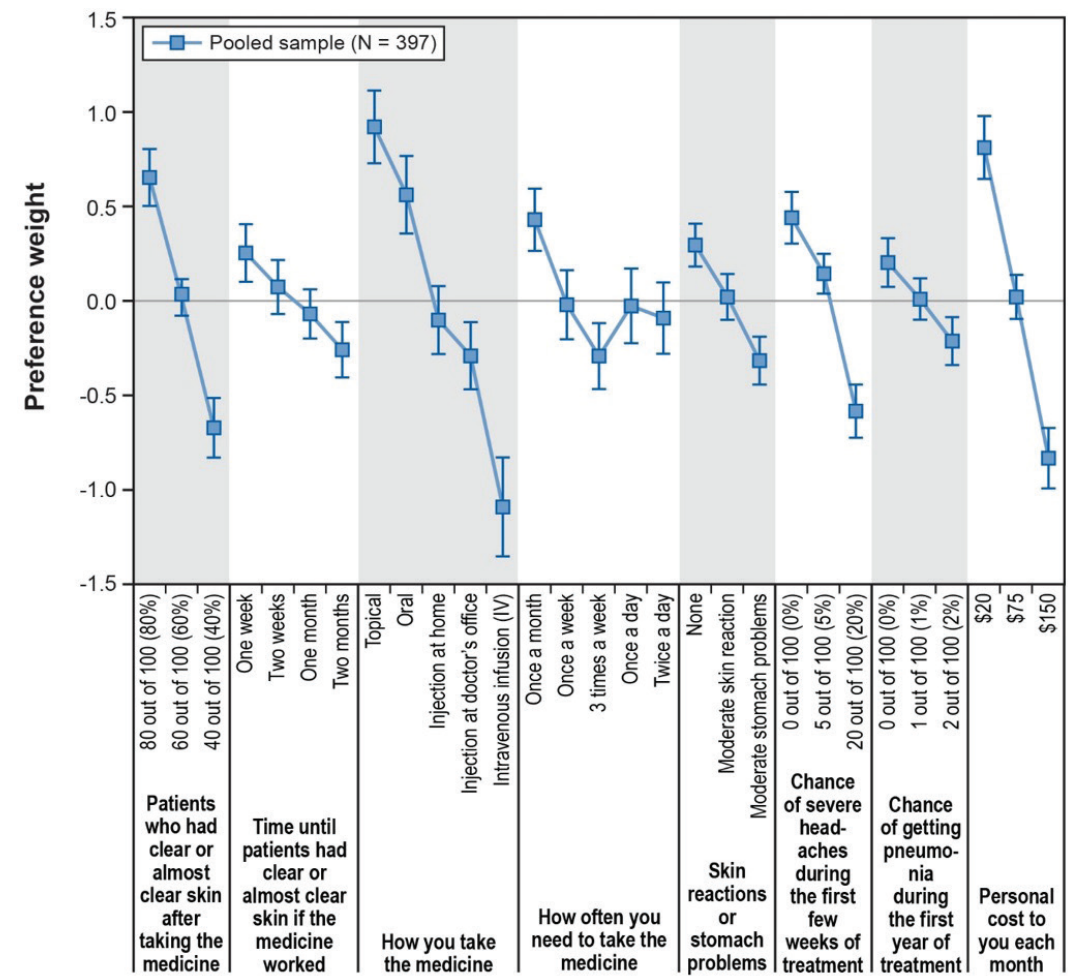
Figure 2. Patient Preference Weights (N =